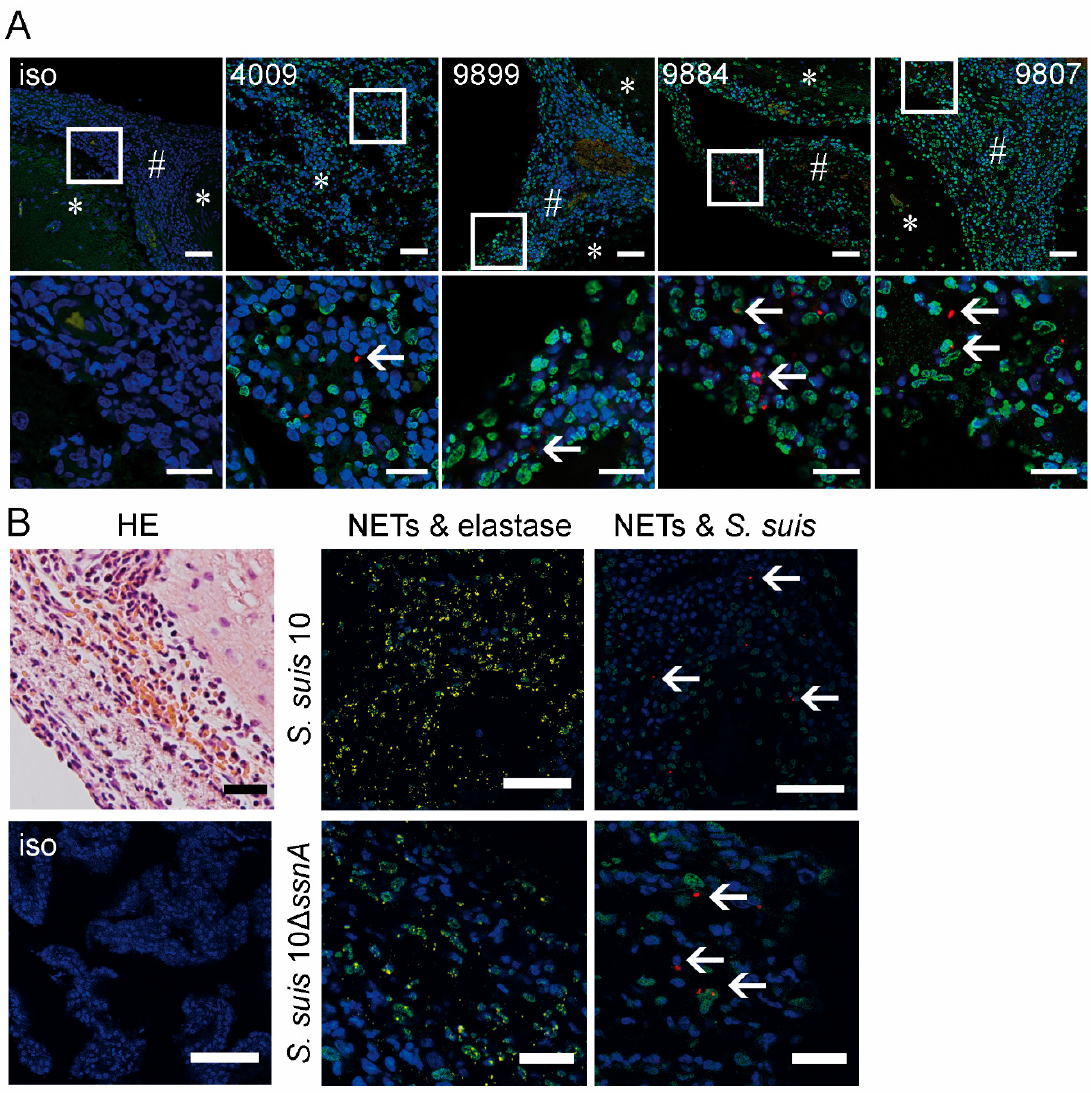
Figure 3. NET-markers are present in brain tissue of piglets with meningitis in situ, but no NET-fibers are detectable. ( A ) In the staining of formalin-fixed brain tissue from pigs out of survival experiments, NET markers and S. suis were visualized, but no NET fibers. * cortex cerebri and # inflammation in meninges (blue = counterstaining of DNA (DAPI); green = DNA/histone-1-complexes (NETs); red = S. suis (white arrow); iso = isotype control; 4009 = animal with meningitis from this survival experiment study; 9899, 9884 and 9807 = pigs with meningitis from other survival experiment study [2,14] (scale bar upper panel = 50 µm; lower panel = 20 µm). ( B ) Representative hematoxylin-eosin (HE) stained tissues of meningitis show neutrophils invading from vessels into the meninges. This picture was observed in both infection groups of the early phase experiment. NET markers (green = DNA/histone-1-complexes (NETs) and yellow = neutrophil elastase) and Streptococci (red) were found in brain tissue of these animals in both infection groups; however, as in the survival experiment, no NET fibers were detectable. Representative pictures are shown; white arrows = S. suis . The pictures for both infection groups present slides that were sliced successively (scale bar HE, isotype and S. suis 10 = 50 µm, S. suis 10 Δ ssnA = 20 µm). Respective isotype controls were used to adjust the settings.